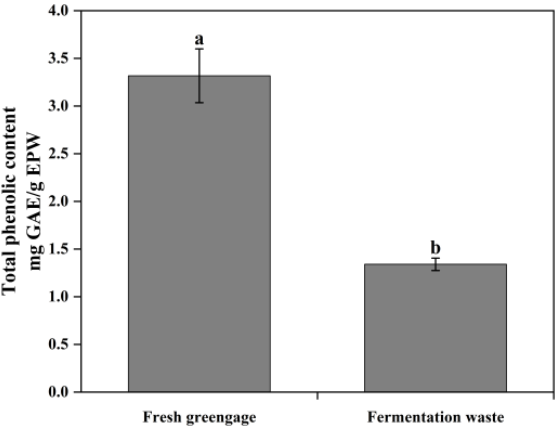
Figure 2. Total phenolic contents of fresh greengage and its fermentation waste. The data are shown as the mean values of three determinations (n = 3) ± standard deviation (error bars). Different letters indicate that they are significantly different at p < 0.05 according to ANOVA analysis.